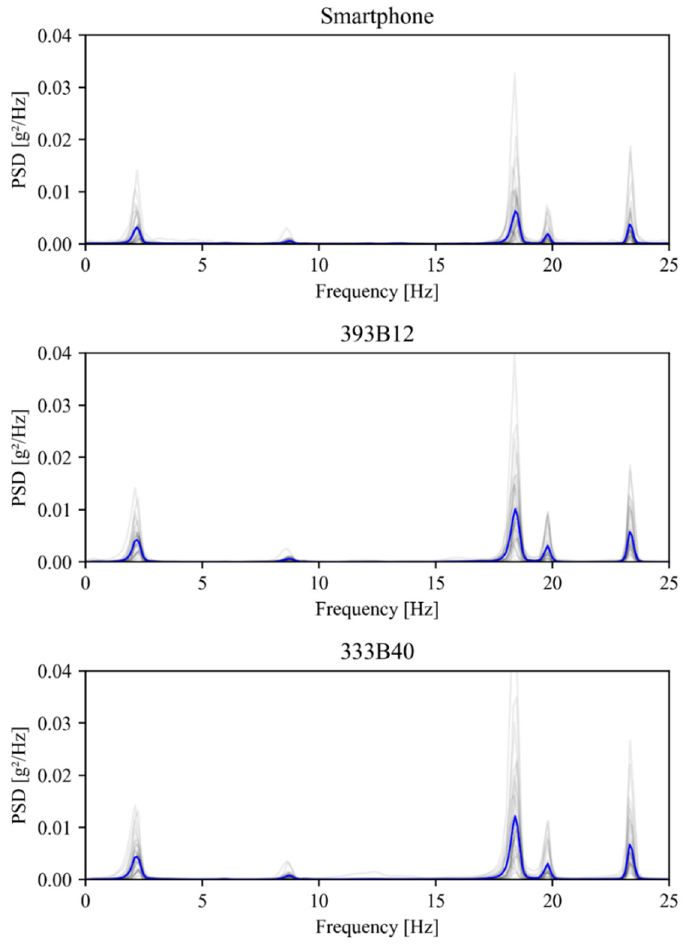
Figure 10. Individual (grey lines) and average (blue lines) power spectral densities (PSDs).